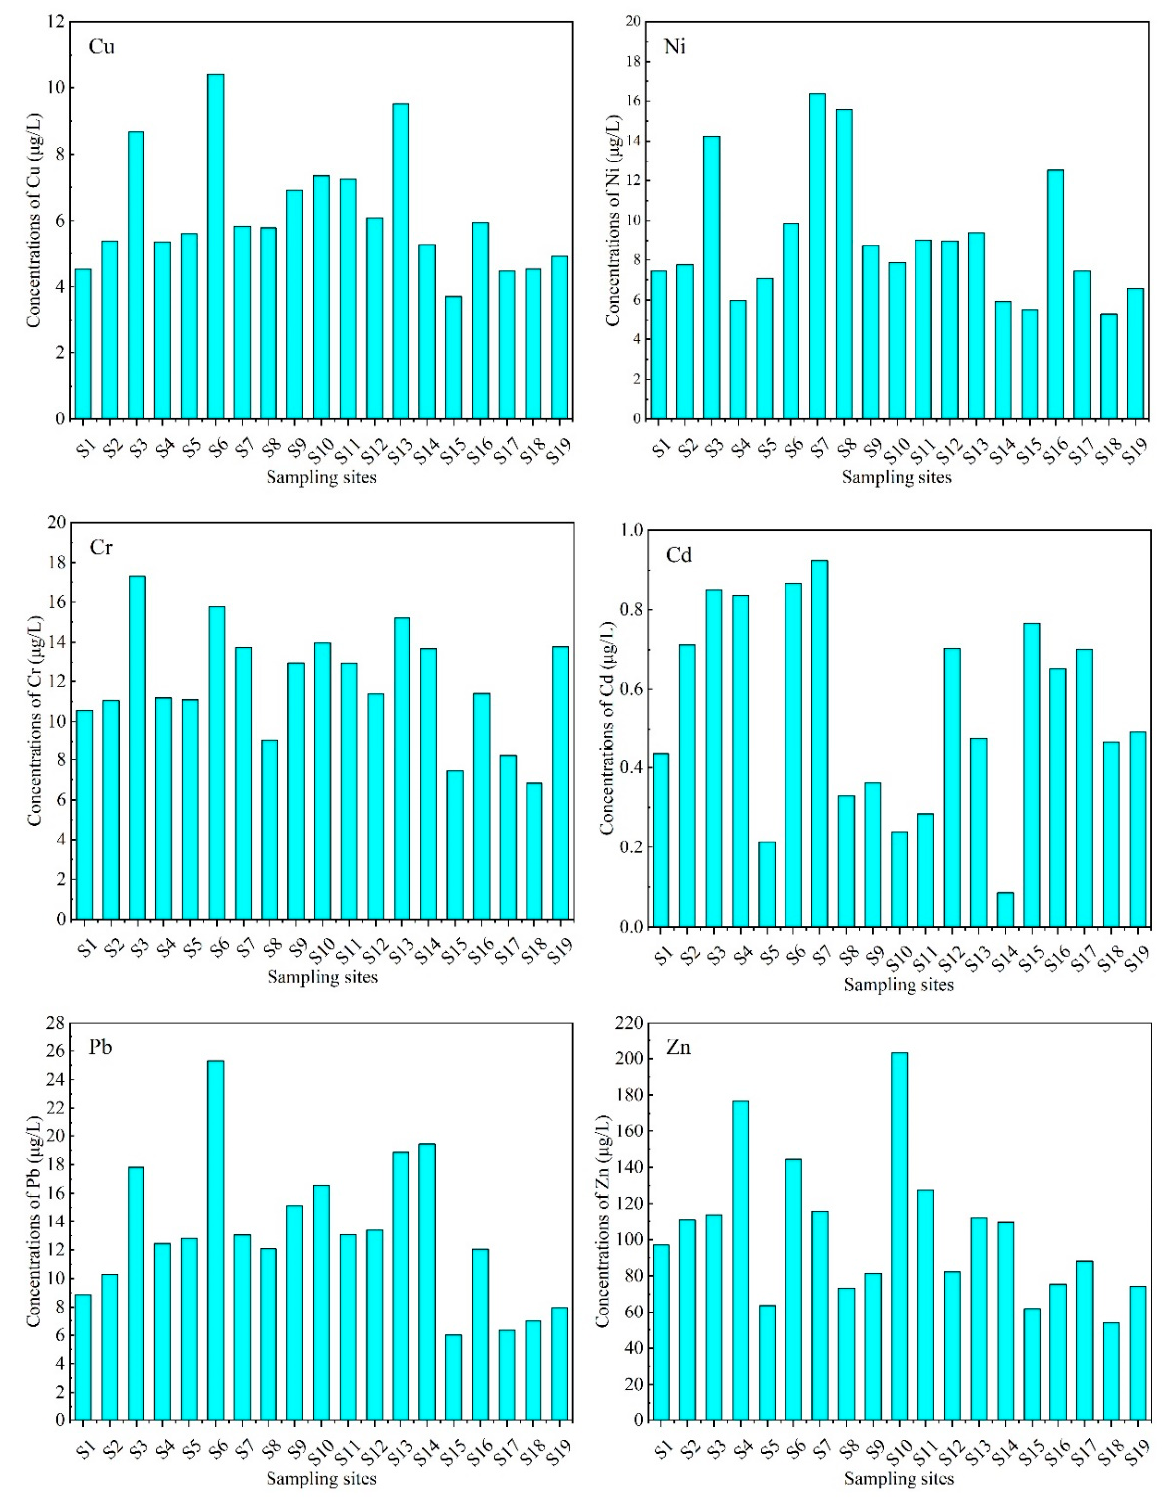
Figure 2. Concentrations of heavy metals in snow cover of Qixing River wetland.